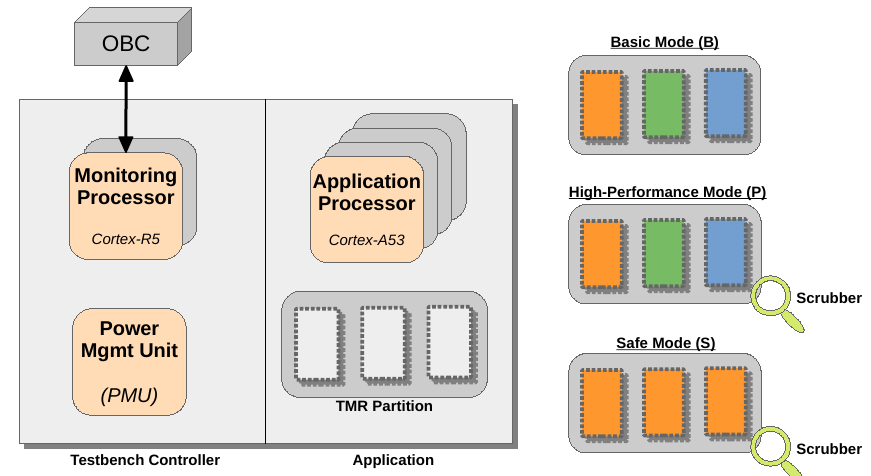
Figure 5. Prototype Testbench.